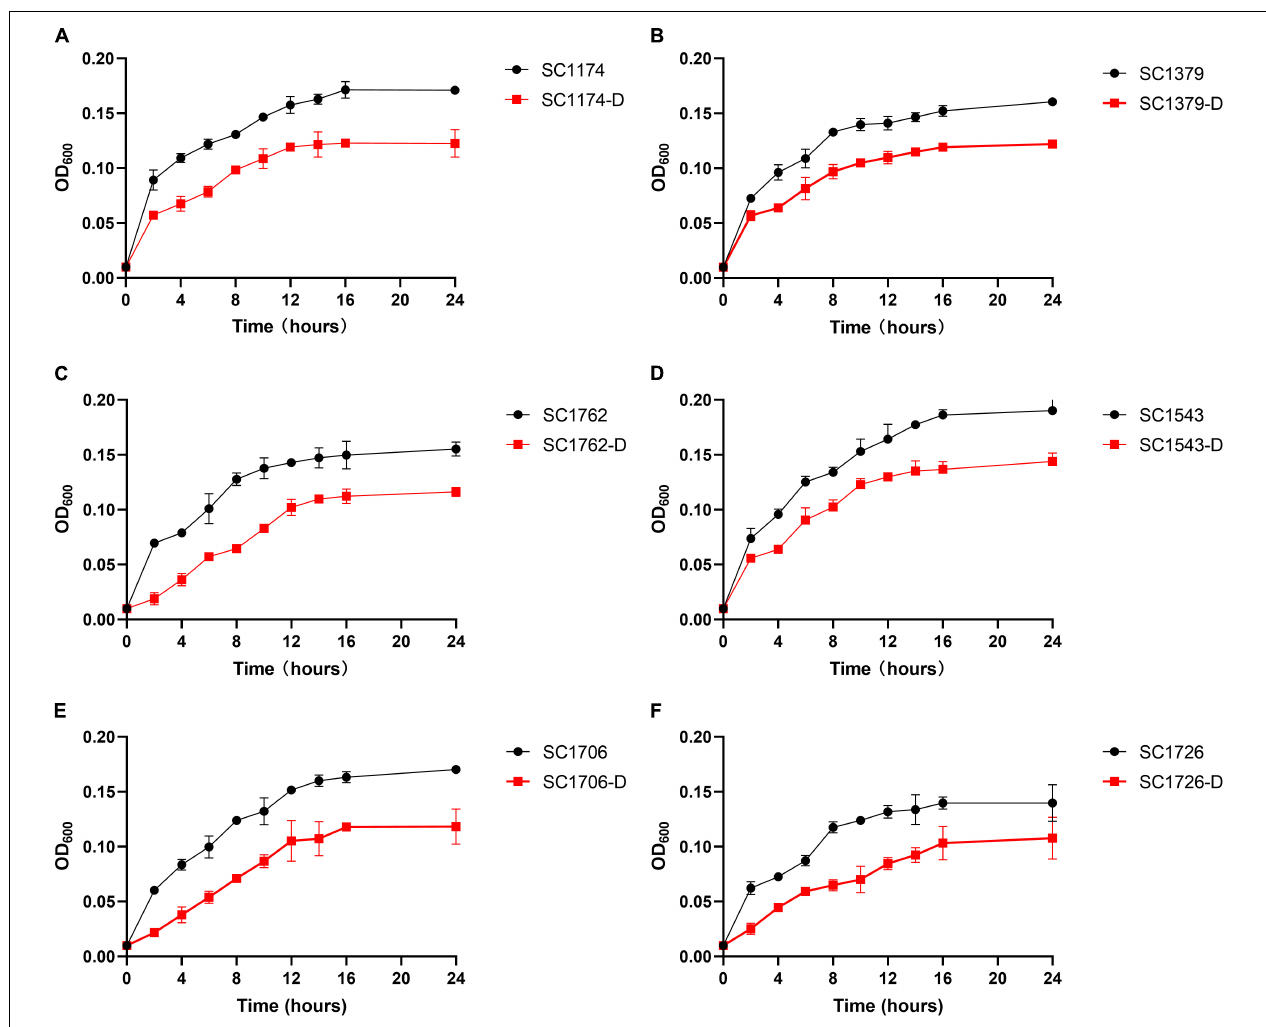
FIGURE 8 | Bacterial growth curves for the parental strains and evolved strains. (A–F) show the growth curves for SC1174, SC1379, SC1762, SC1543, SC1706, SC1726, and their corresponding evolved DAP-R mutants, respectively. The standard deviation of three independent experiments is indicated in error bars. One-way analysis of variance (ANOVA) was used in statistical analysis ( P < 0.05 vs. respective DAP-S parental strains).